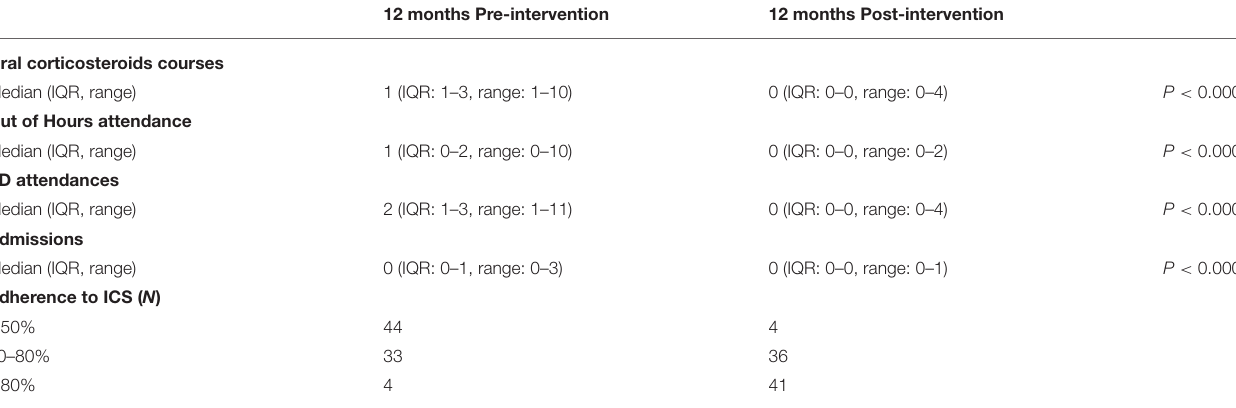
TABLE 2 | For the RBHSC. 12 months Pre-intervention 12 months Post-intervention